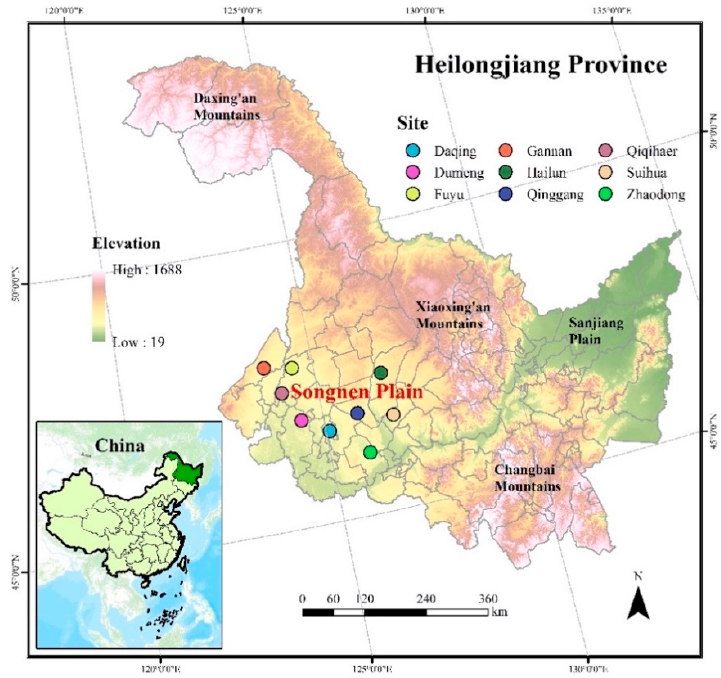
Figure 1. Location of the Songnen Plain, where our study sites and sampling plots are located.